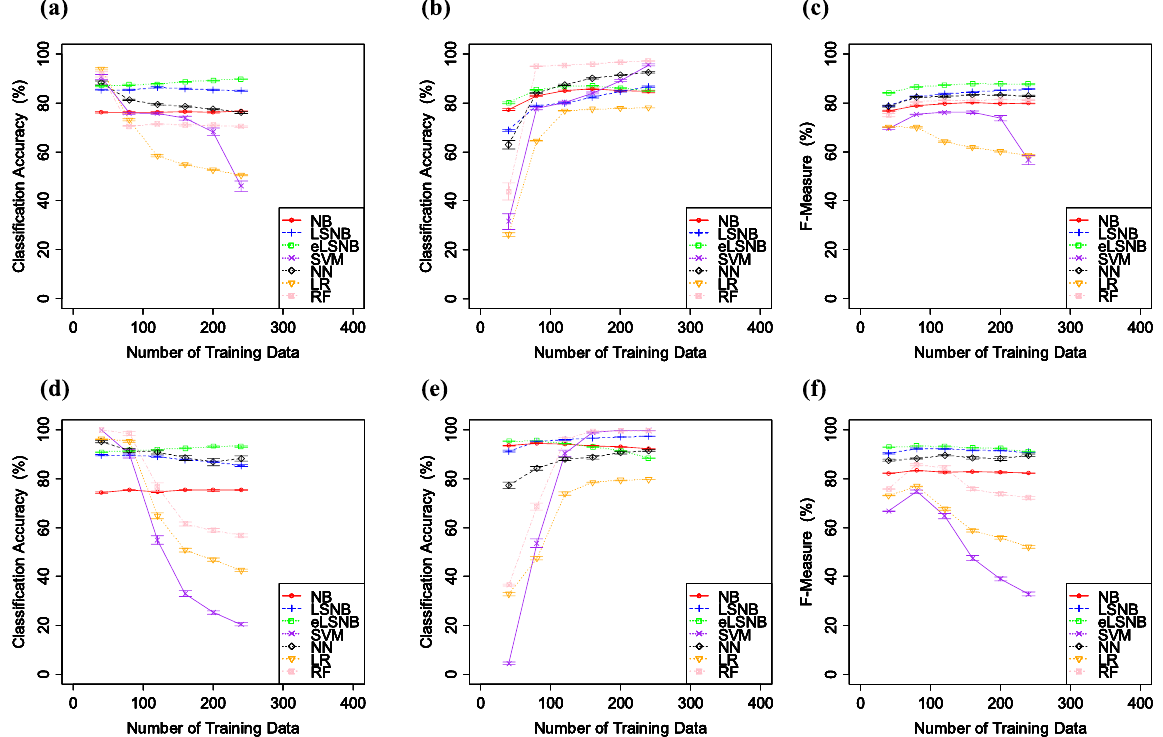
Figure 5. ( a ) spam classification accuracy, ( b ) ham classification accuracy and ( c ) F-measure values for SpamAssassin. ( d ) spam classification accuracy, ( e ) ham classification accuracy and ( f ) F-measure values for Ling-Spam. The number of spam training data points was predefined at 100. Error bars indicate the standard